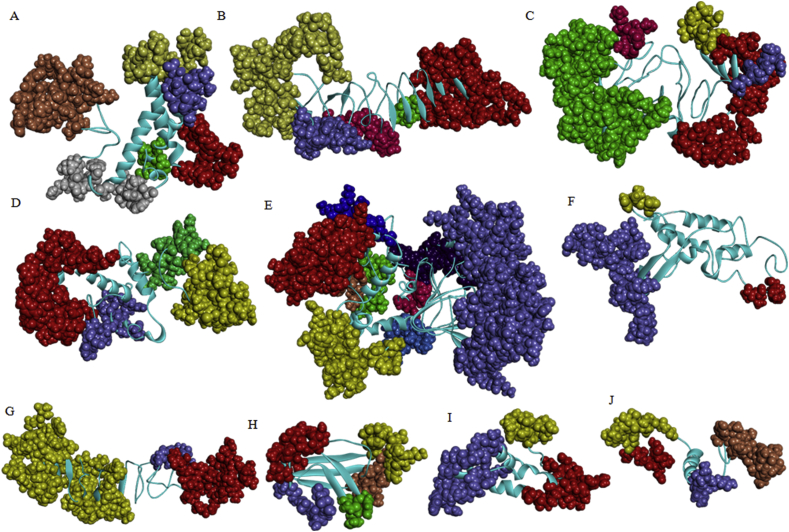
Structure prediction and validation of final multi-epitope constructs. Ramachandran plot analysis of the simulated structures. Summary of residues in favored, allowed and in outlier part is provided in Table 4.